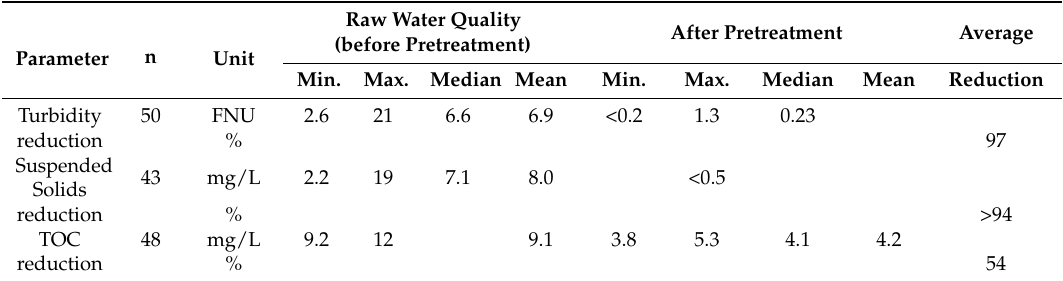
Table 3. Raw water quality (River Kokemäenjoki) and pretreatment results at the Virttaankangas MAR plant in 2015. Definition: TOC = total organic